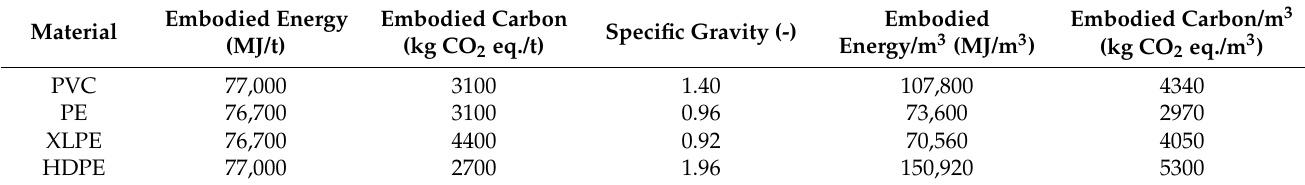
Table 4. GHG emissions and embodied energy of plastic insulating materials [75,78–83].